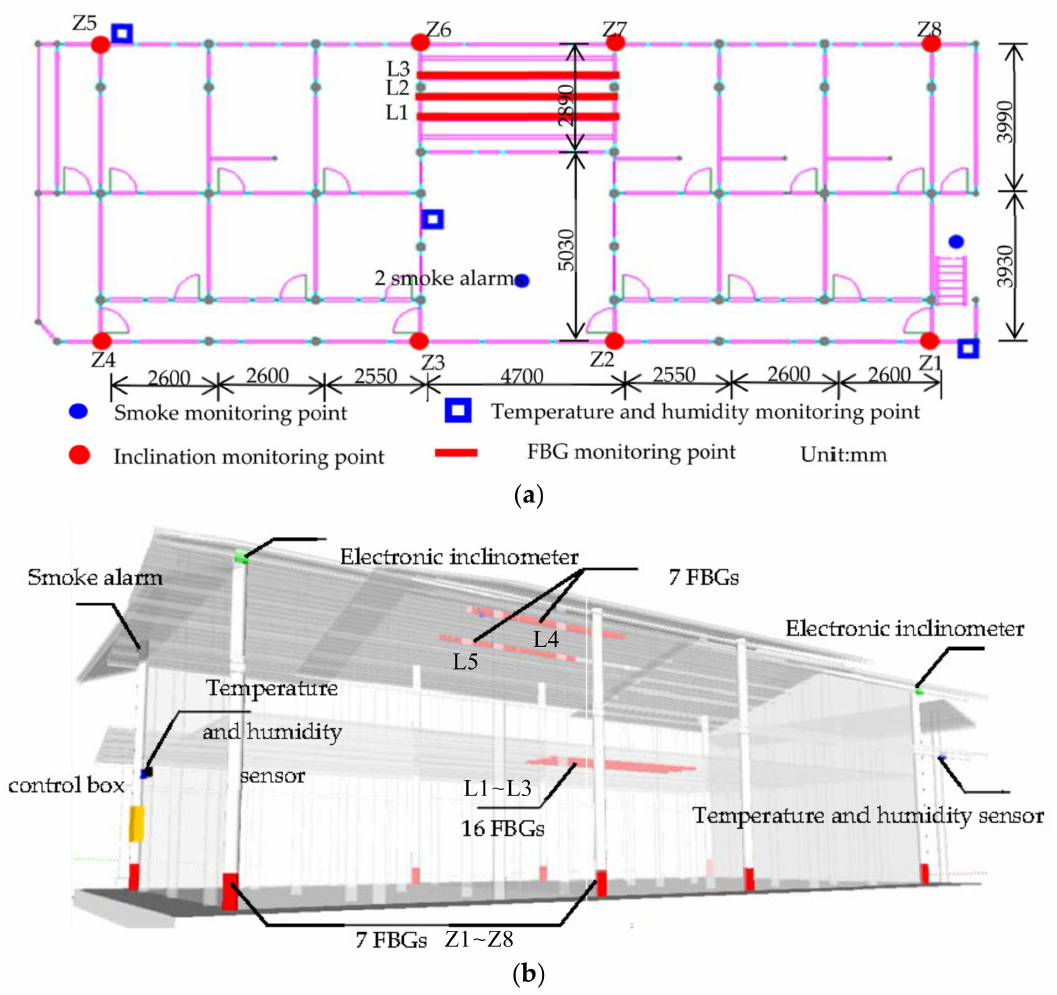
Figure 3. Layout of sensors in Seven Literary World: ( a ) Layout of sensors of the first floor plan; ( b ) Lateral